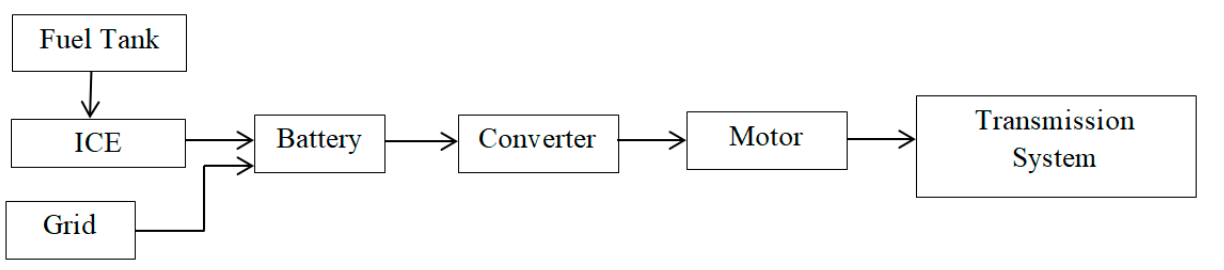
Figure 2. Block Diagram of a PHEV.